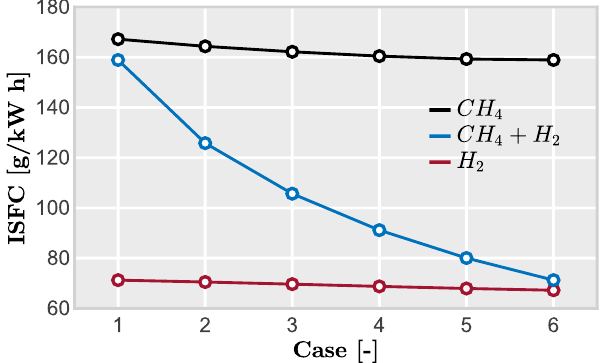
Figure 18. Specific fuel economy of all simulated conditions. The black line corresponds with the CNG simulation plan, sweeping the air dilution from λ = 1 to λ = 1.5. The blue line sweeps the amount of hydrogen in the fuel from 0% to 100%. The red line considers pure hydrogen combustion varying λ from 1.5 to